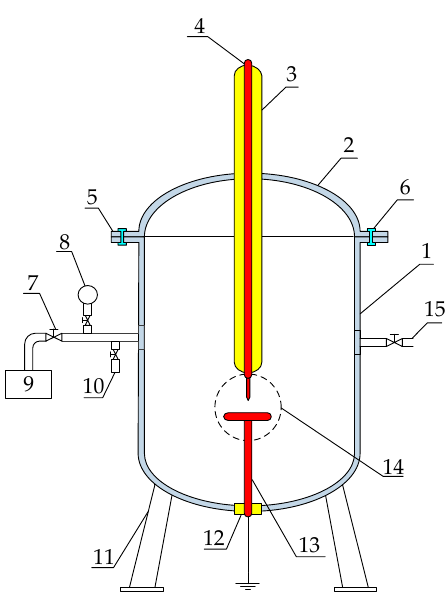
Figure 2. Structure of the gas chamber: 1 stainless-steel shell; 2 top cover; 3 HV bushing; 4 HV conductor; 5 flange; 6 screw; 7 ball valve; 8 vacuum pressure gauge; 9 vacuum pump; 10 injection port; 11 supporting foot; 12 epoxy loop; 13 ground conductor; 14 insulation defect; and 15 sampling port.